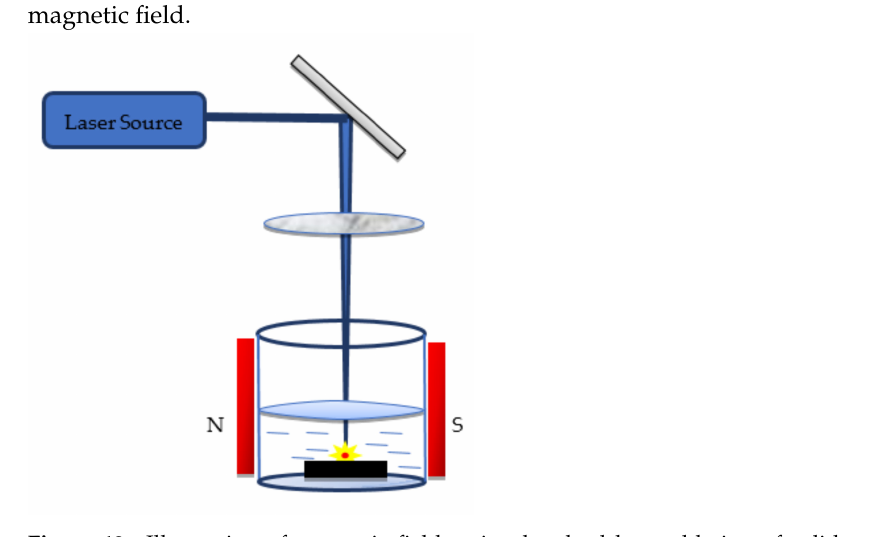
Figure 13. Illustration of magnetic field-assisted pulsed laser ablation of solid metal targets in liquid